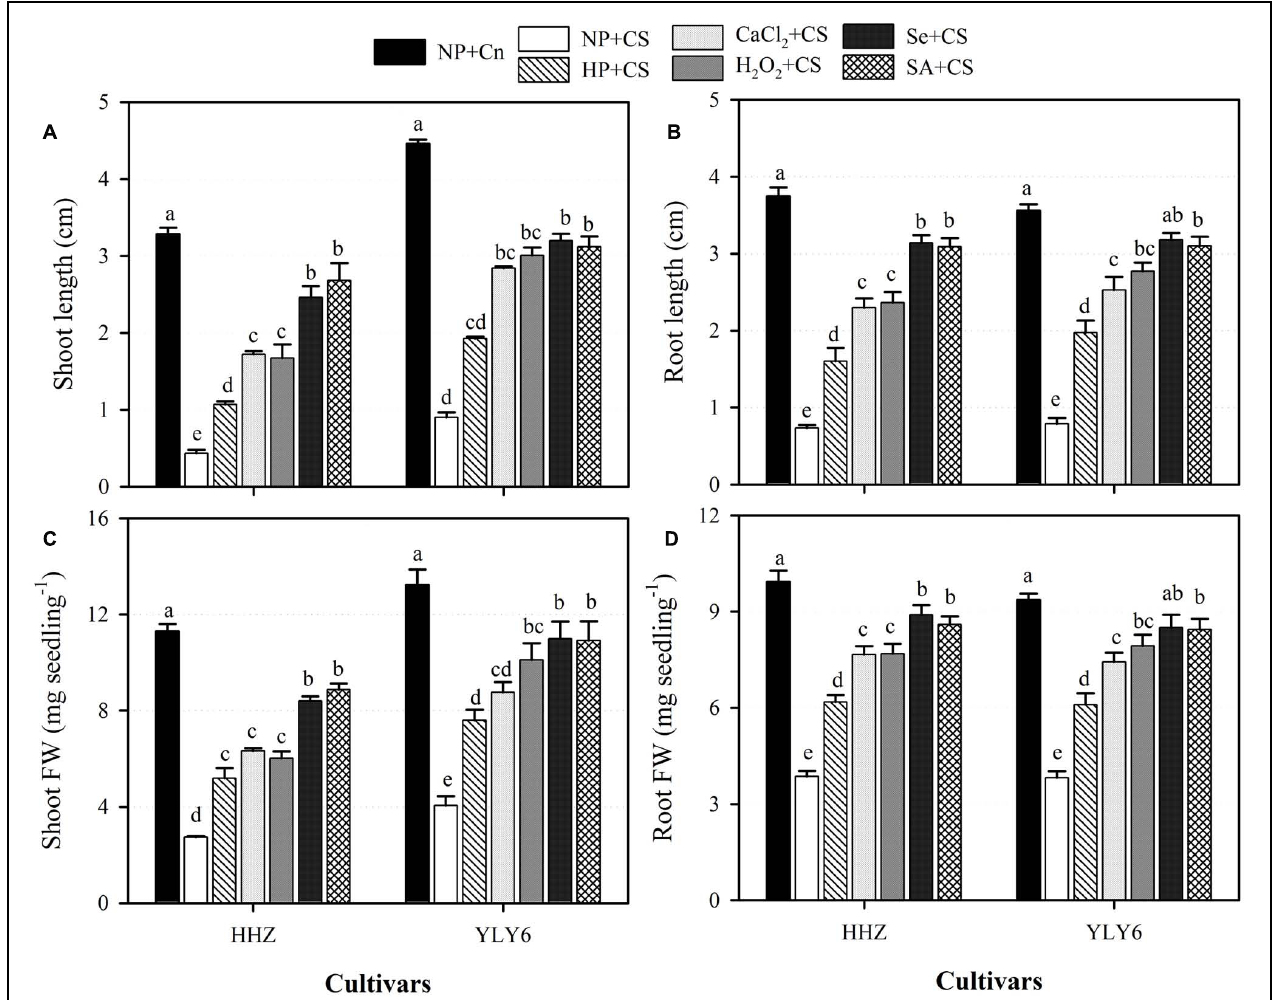
FIGURE 2 | Influence of various seed priming treatments on (A) shoot length, (B) root length, (C) shoot fresh weight, and (D) root fresh weight of two rice cultivars under chilling conditions. Vertical bars above mean indicate standard error of six replicates. Mean value for each treatment with different lowercase letters indicate significant differences by the LSD-test ( P < 0.05). NP + Cn: no priming and no stress, NP + CS: no priming and chilling stress, HP + CS: hydropriming and chilling stress, CaCl 2 + CS: calcium chloride priming and chilling stress, H 2 O 2 + CS: hydrogen peroxide priming and chilling stress. Se + CS: selenium priming and chilling stress, and SA + CS: salicylic acid priming and chilling stress, Cn: 28 ◦ C, CS: 18 ◦ C, HHZ: inbred cultivar huanghuazhan, YLY6: hybrid variety